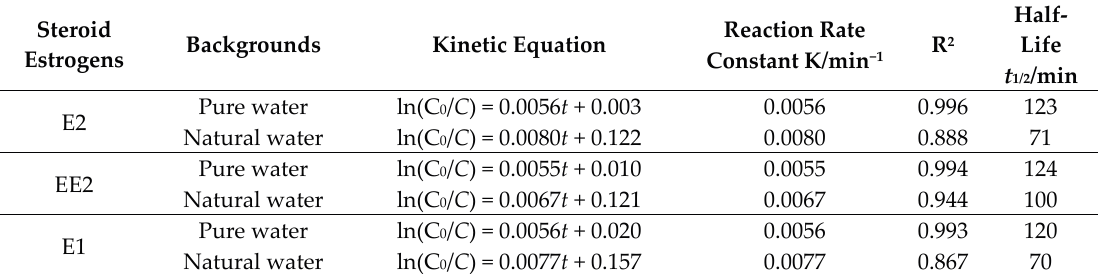
Table 6. Parameters of kinetic model of degradation of steroid estrogens under different aqueous